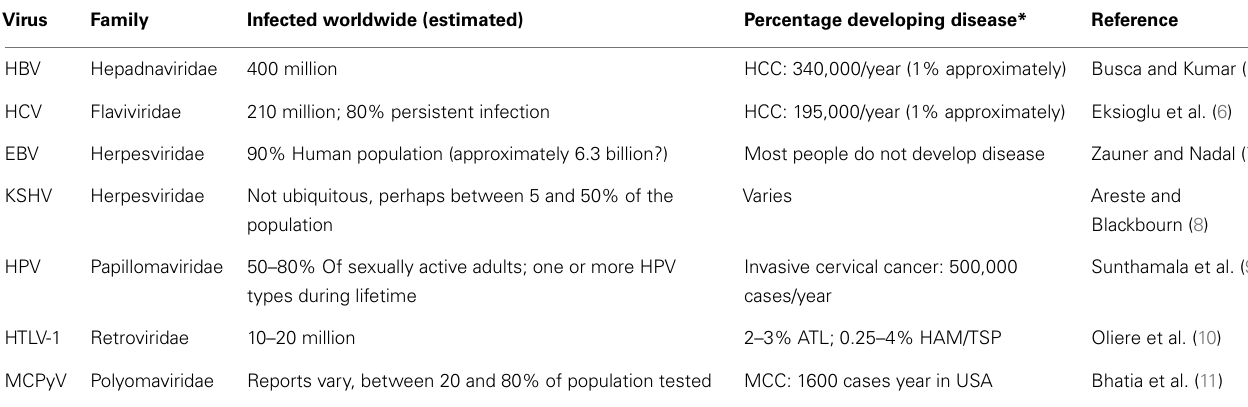
Table 1 | Oncoviruses induce cancer in only a fraction of infected humans